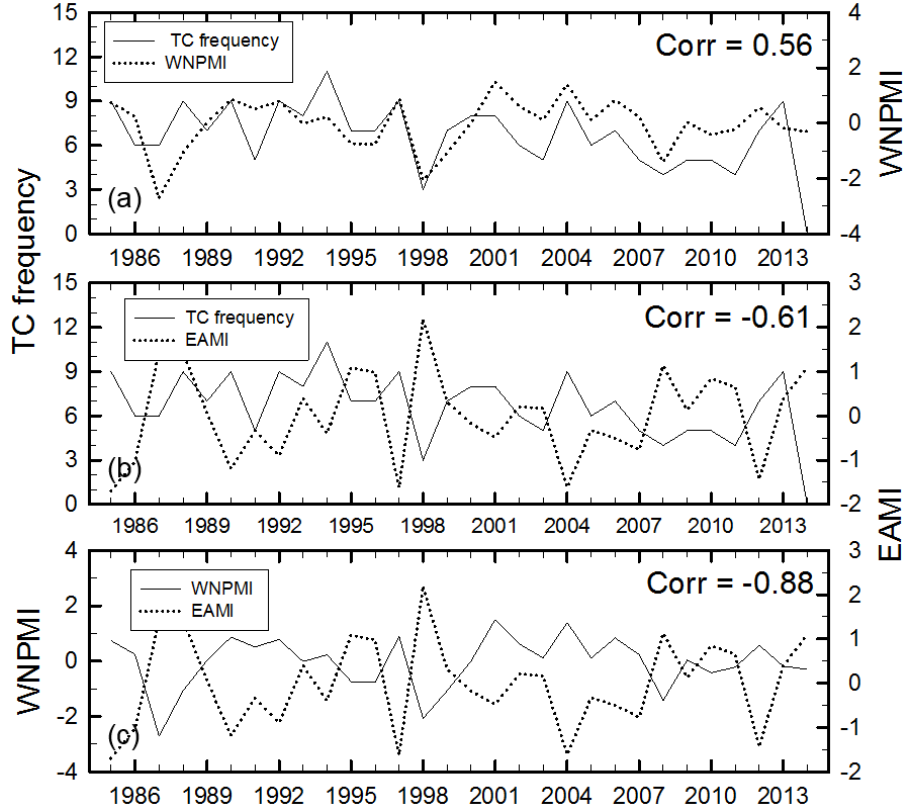
Figure 3. Time series of ( a ) TC genesis frequency and western North Pacific monsoon index (WNPMI); ( b ) TC genesis frequency and East Asian monsoon index (EAMI); and ( c ) WNPMI and EAMI.